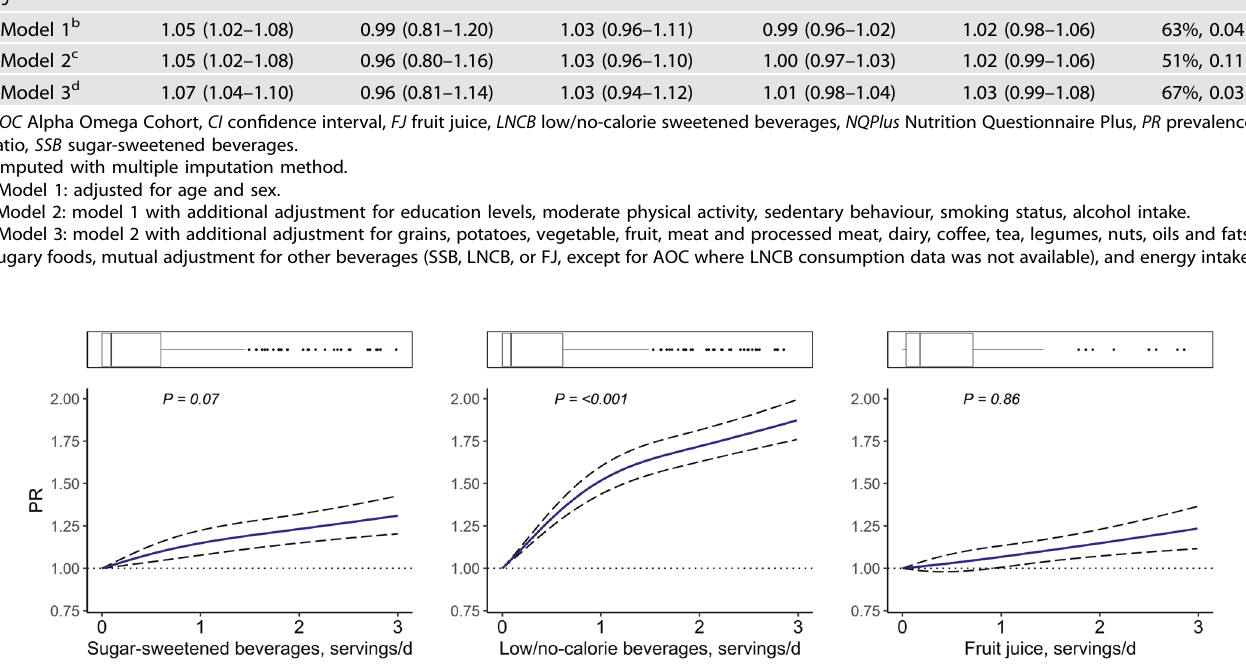
Fig. 1 Dose – response associations of SSB, LNCB and FJ intakes with FLI-de fi ned NAFLD in Lifelines. Three knots with 0 g/day as a reference value were placed and model was adjusted for age, sex, education levels, moderate physical activity, sedentary behaviour, smoking status, alcohol intake, grains, potatoes, vegetable, fruit, meat and processed meat, dairy, coffee, tea, legumes, nuts, oils and fats, sugary foods, mutual adjustment for other beverages (SSB, LNCB, or FJ), and energy intake. CI con fi dence interval, FJ fruit juices, LNCB low/no-calorie sweetened beverages, PR prevalence ratio, SSB sugar-sweetened